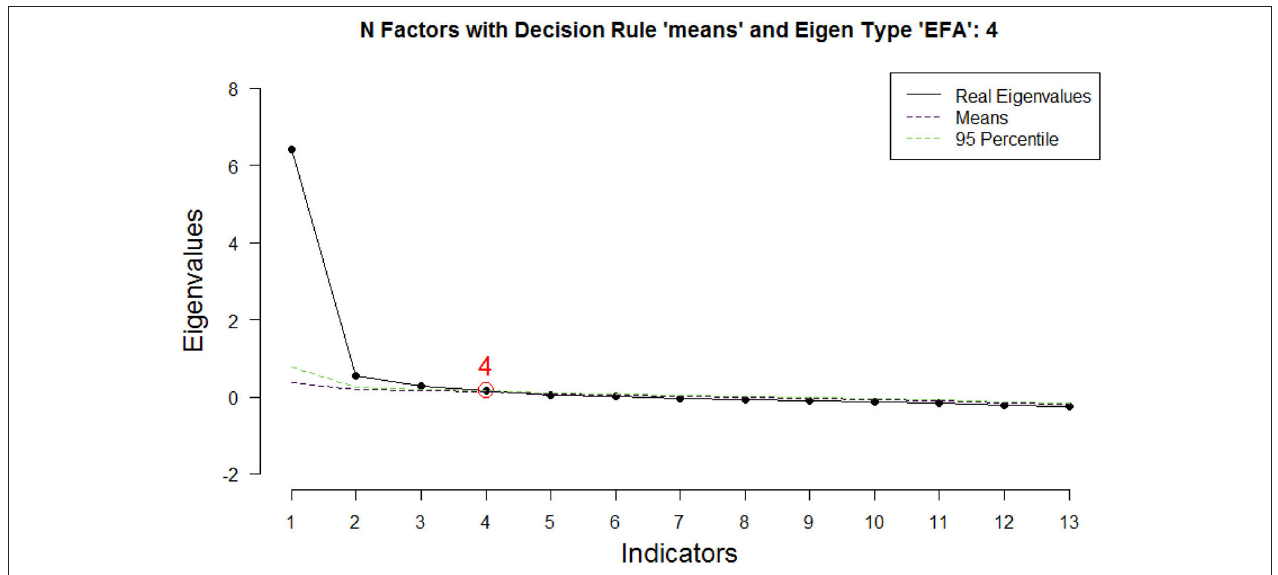
FIGURE 1 | Scree plot of the 13-item EFA model.